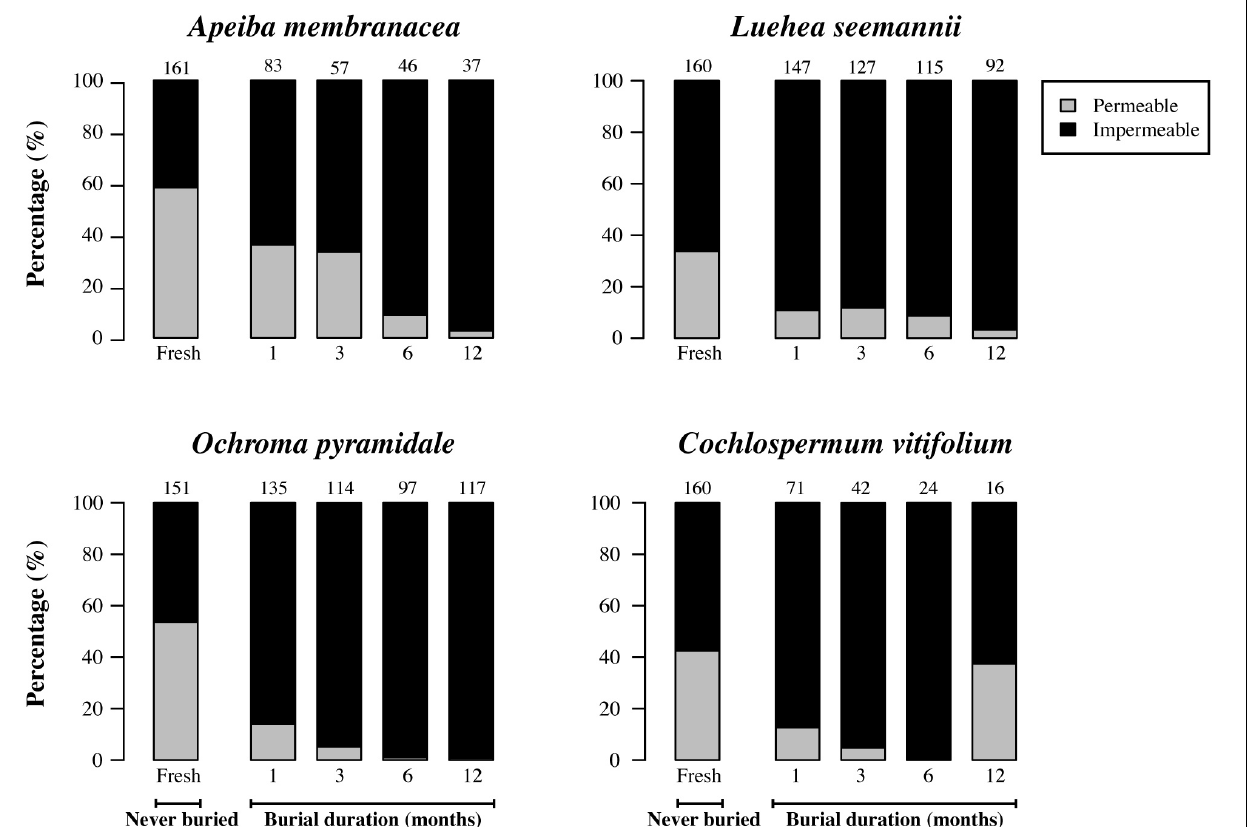
FIGURE 6 | Percentage of permeable seeds (gray) and impermeable seeds (black) for fresh (unburied) seeds, and seeds successfully recovered at different time intervals after burial. Numbers at the top of